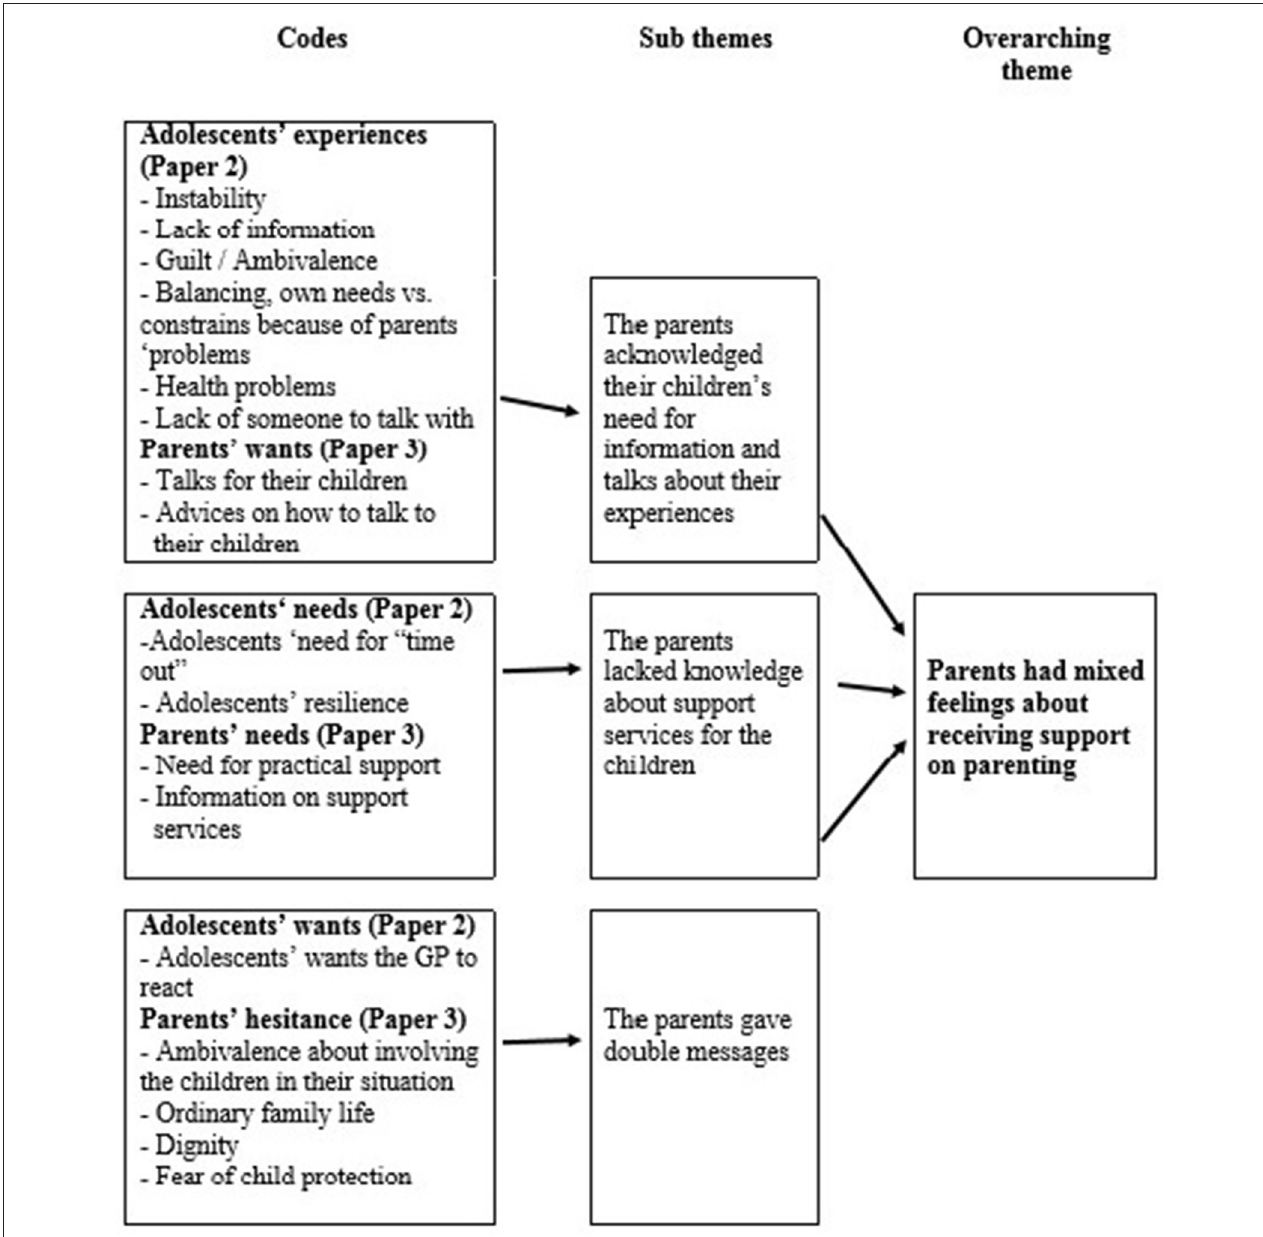
FIGURE 1 | Analysis process from codes over sub-themes to overarching themes. Result section “Patients had mixed feelings about receiving support on parenting” as an